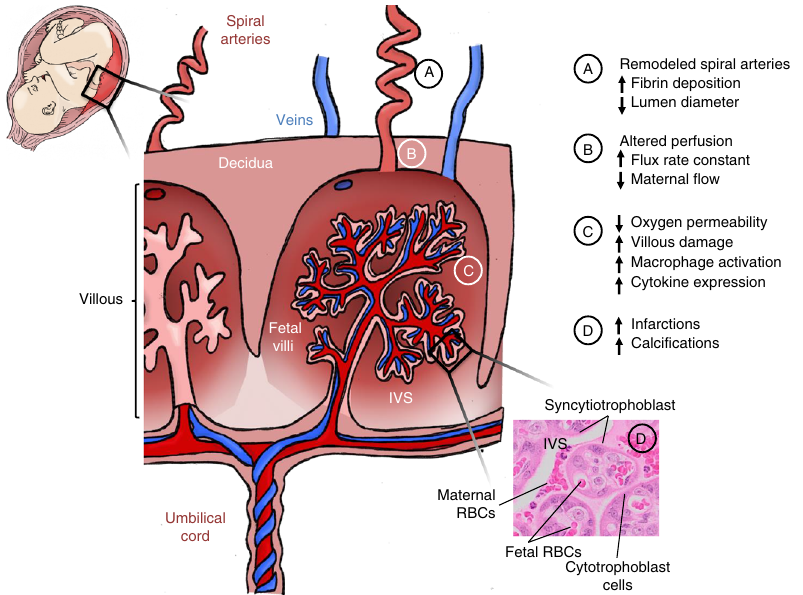
Fig. 9 Schematic summary of placental damage following maternal ZIKV-infection. Cross section diagram of placental vasculature demonstrating maternal spiral arteries that perfuse the intervillous space. Notations A – D summarize the placental tissue damage, alterations in perfusion, and immune response to ZIKV infection during